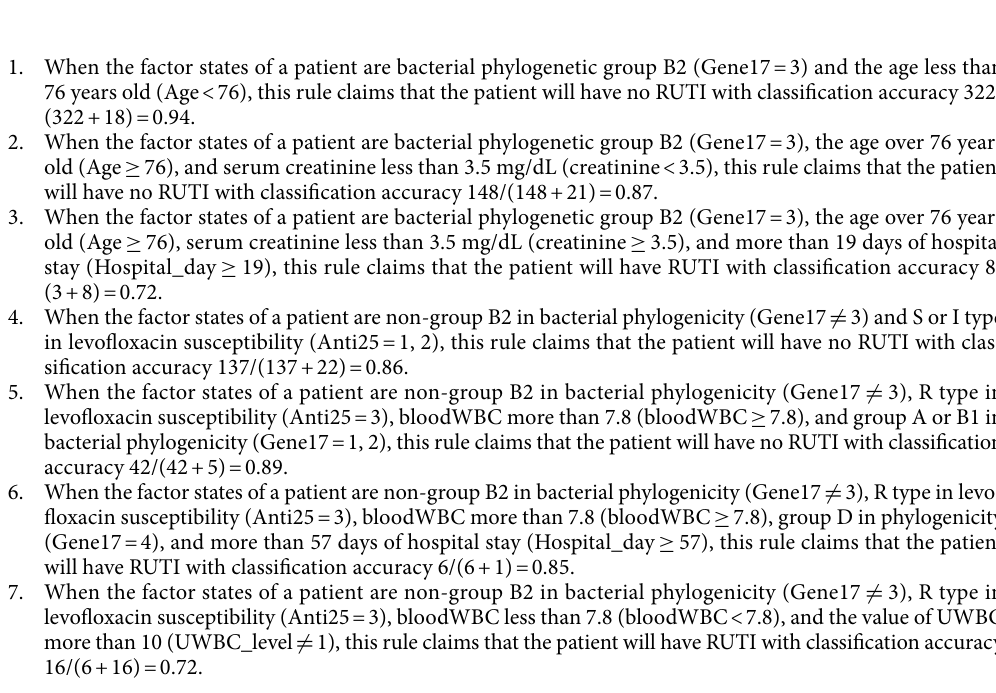
Figure 4. The decision rules of the DT analysis for development of RUTI after hospitalization. The 4 green boxes and 3 red boxes indicate the nodes of the decision rules with an accuracy rate higher than 0.85 and 0.70 for non RUTI and RUTI classification, respectively (sample size =